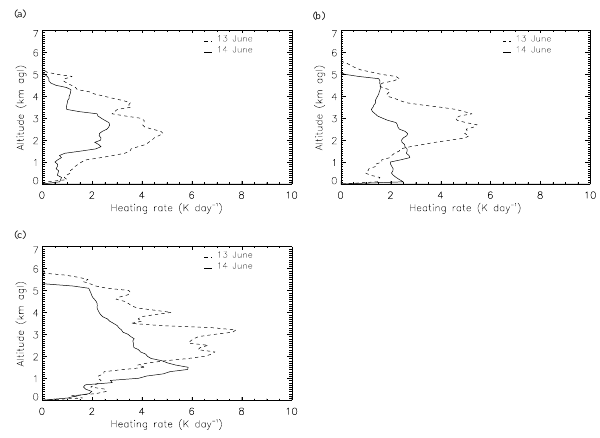
Fig.12. HeatingrateprofilesderivedfromLEANDRE2on13June(dashedline)and14June(solidline)at10 ◦ N (a) ,12 ◦ N (b) and14 ◦ N (c) withtheRaCHmodel. Fig. 12. Heating rate profiles derived from LEANDRE 2 on 13 June (dashed line) and 14 June (solid line) at 10 ◦ N (a) , 12 ◦ N (b) and 14 ◦ N (c) with the RaCH model.